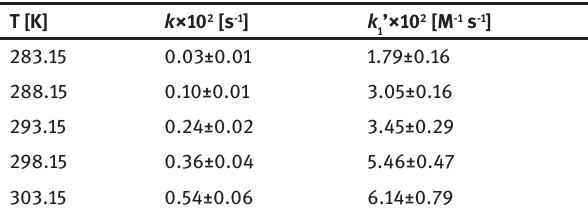
’ = k ∙ K (M -1 s -1 ) for the aquation 1 1 O] + = 0.15 M, ionic strength (Na + , 3